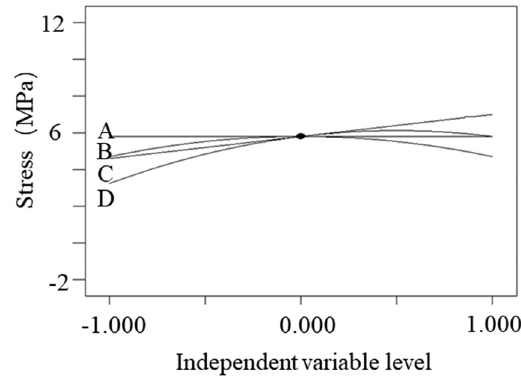
Figure 5: Single factor impact analysis diagram of σ 3 .